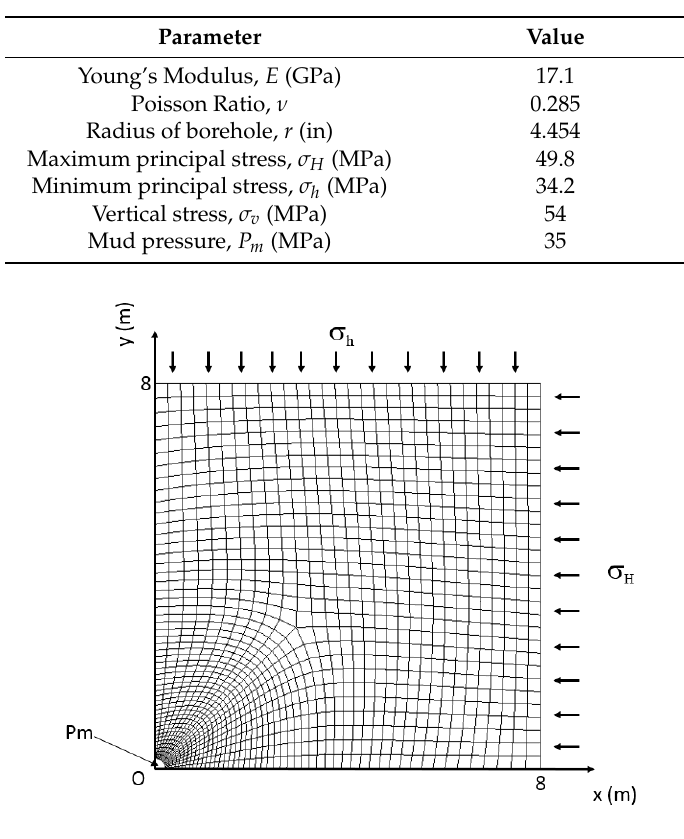
Table 5. Calculated deformation from the estimated parameters using FEM.